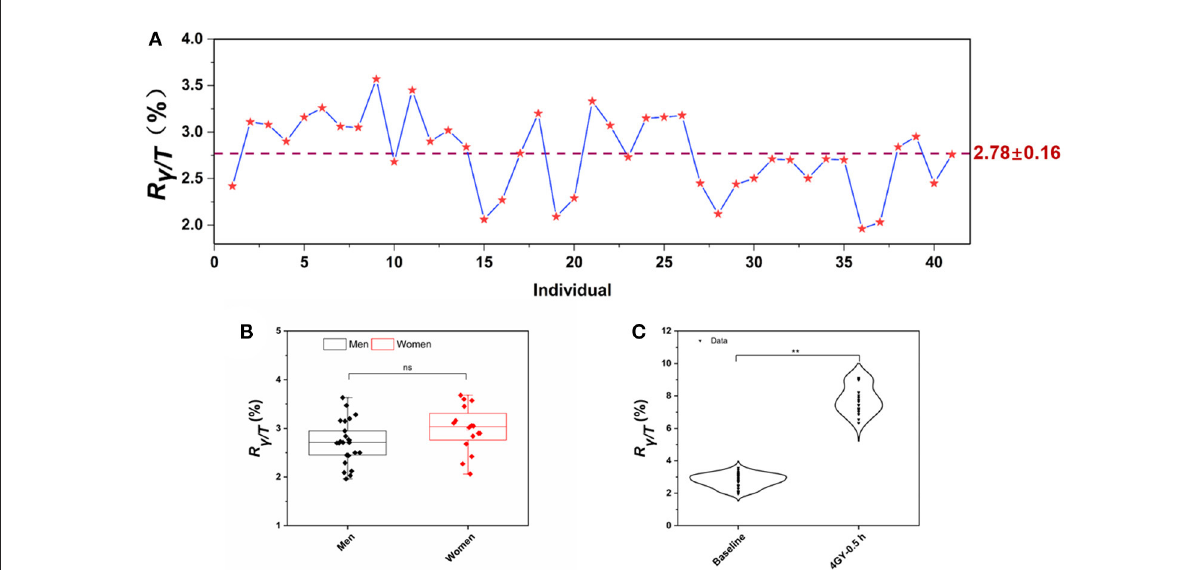
FIGURE5 γ -H2AX signal in healthy human donors. (A) The background levels of R γ/ T in peripheral blood lymphocytes from 41 healthy human donors, (B) dot-whisker plot of γ -H2AX levels between gender groups, and (C) comparison of γ -H2AX levels in the lymphocytes of peripheral blood exposed to γ -ray in the dose of 4Gy at 0.5h post-irradiation with those of sham-exposed blood. ( n ≥ 3, mean ± SD, ns p > 0.05, ** p ≤